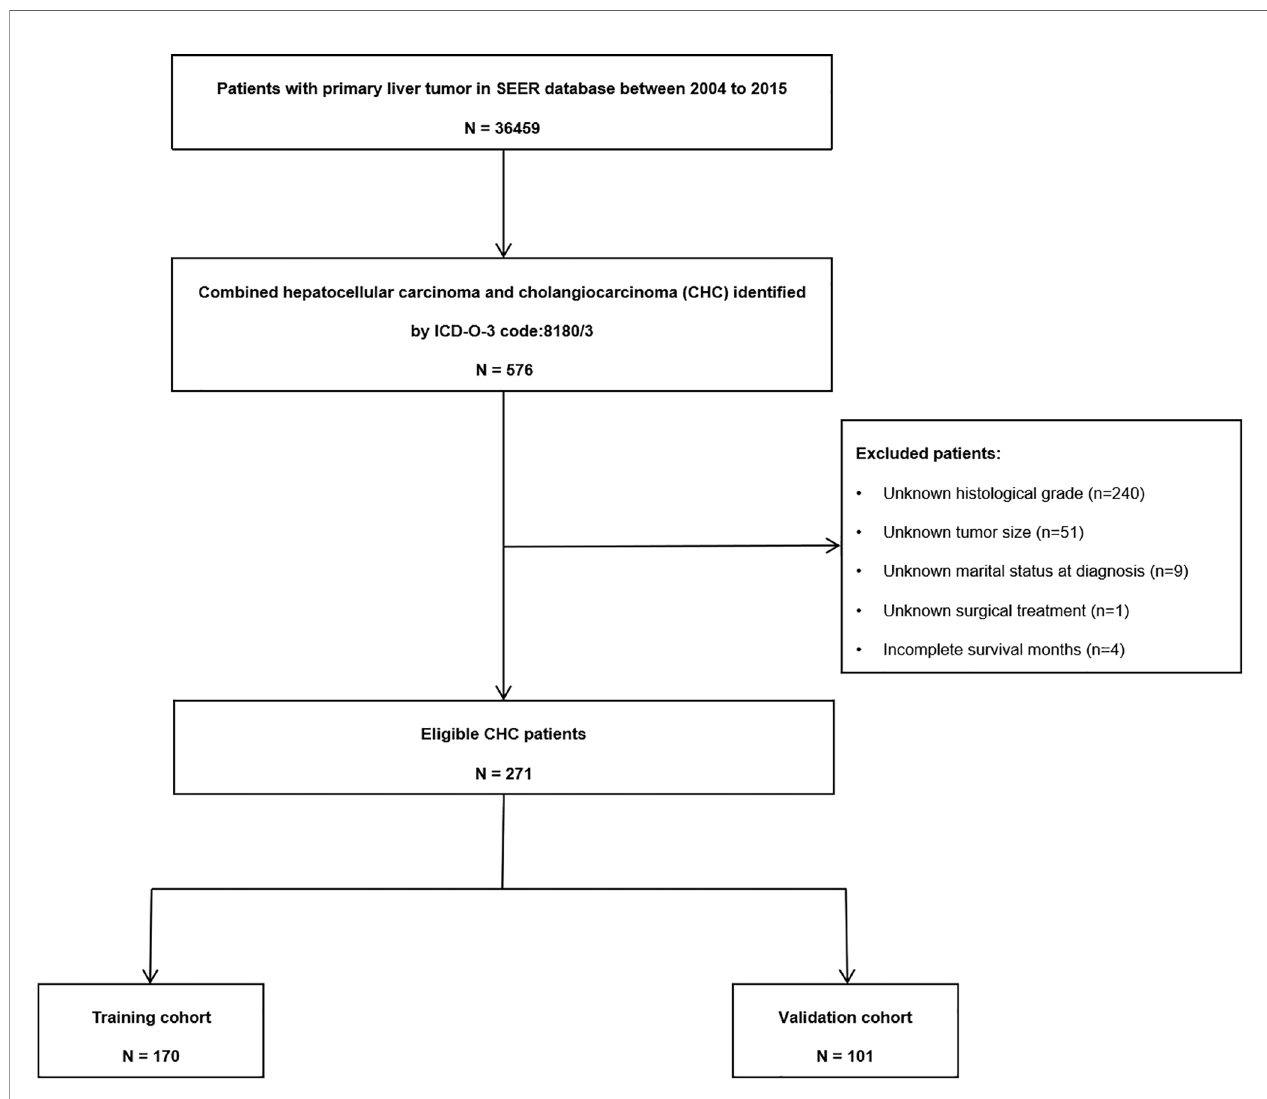
FIGURE 1 | Flow chart of the combined hepatocellular carcinoma and cholangiocarcinoma